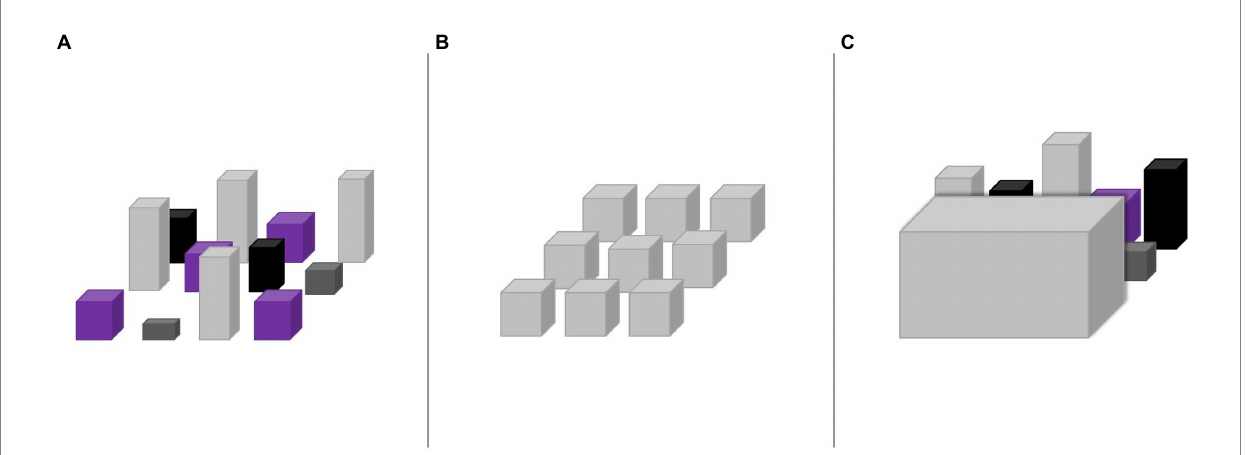
FIGURE 1 Landscapes of relevant affordances (A) meaningful, (B) unattractive, (C) unbalanced. In each image, the gray cubes represent the training in ones’ main sport while the other colors represent other interests, activities, responsibilities, etc. Inspired from Rietveld and Kiverstein (2014, p.